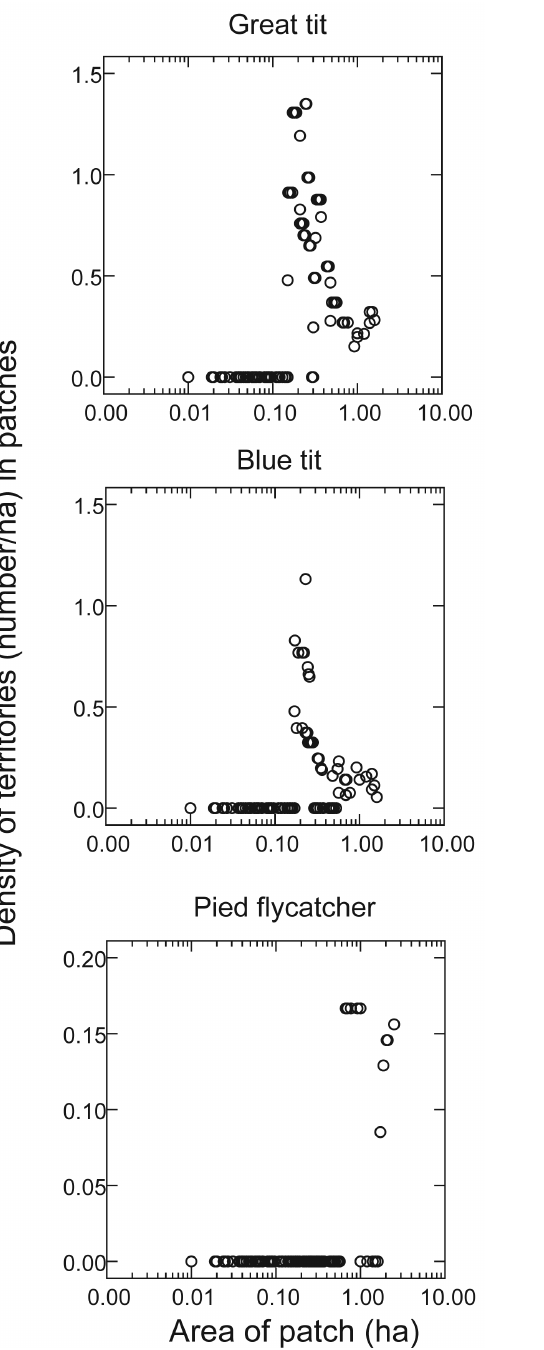
Fig. 1. Patch area and territory density of the three studied bird species. All 135 patches in the descriptive study are included. Patches are sorted by area; the symbols indicate the running aver- age for each patch based on the patch and the five next larger and five next smaller patches. For the Pied fly catcher an average based on two larger and two smaller (rather than five) patches was used (otherwise the 10 largest patches that contained most Pied Fly- catcher breedings would have been missing from the figure).